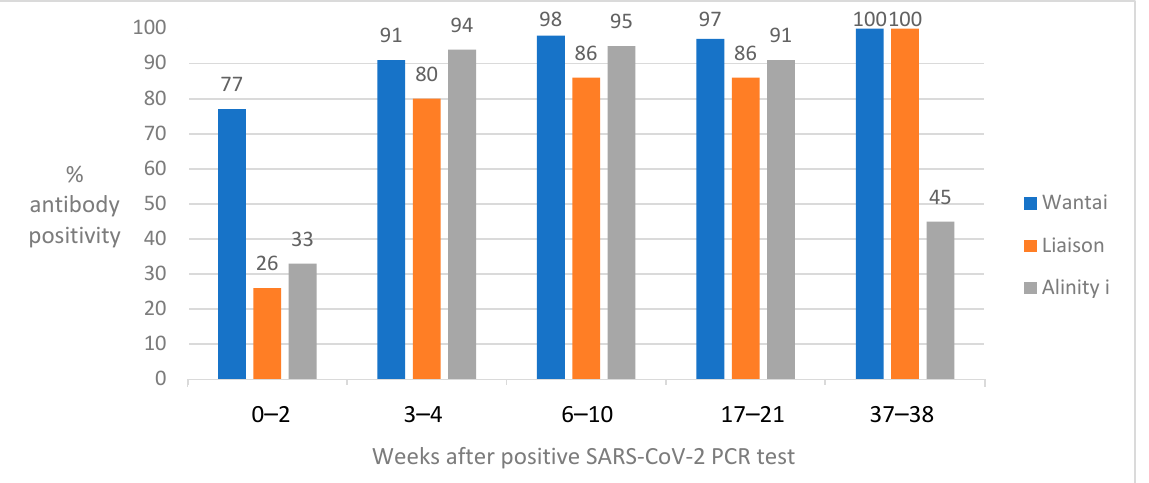
Figure 1. SARS-CoV-2 antibody positivity rates in the Wantai RBD total antibody assay, Liaison S1/S2 IgG assay and Alinity i nucleocapsid IgG assay by analyzing serum samples collected from 46 SARS-CoV-2 infected individuals at two or more time points for up to 38 weeks following PCR positivity. In weeks 37-38, most PCR-positive cases were SARS-CoV-2 vaccinated, resulting in 100% positivity rates in the Wantai RBD total antibody assay and Liaison S1/S2 IgG assay.